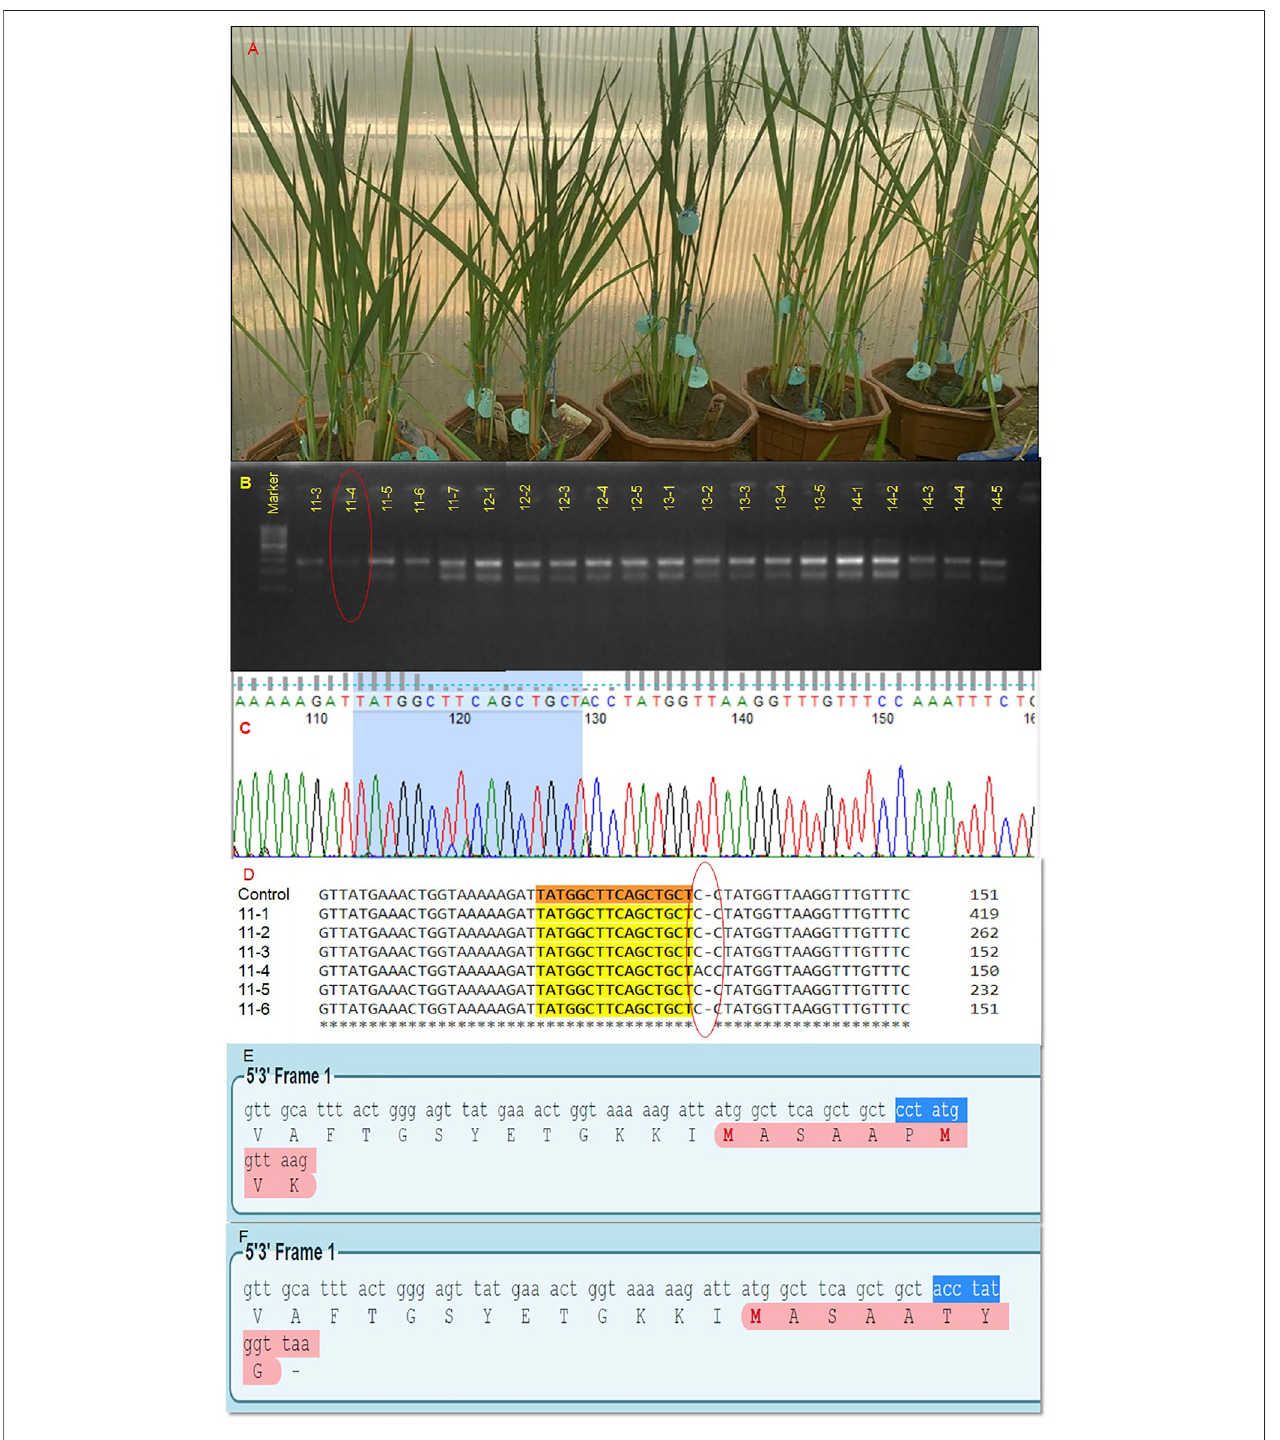
FIGURE 3 | Editing of OsBADH2 gene for generation of aromatic rice using RNP approach. Acclimatized T 0 edited plants for OsBADH2 gene grown under glasshouseconditions (A) ,DetectionofRNP-based editingintheT 0 generationthroughmutationsitebasedspeci fi cprimerstechnique(MSBSP).Encircledlanedepicts the mutation (B) , A electropherogram showing the result of Sanger sequencing (C) , Multiple sequence alignment of putative T 0 plants showing the addition of a nucleotide “ A ” 4-bp upstream of the PAM site (D) , The ORF of OsBADH2 exon seven in PR114 (E) , The ORF of Osbadh2 exon seven in the edited plant, 11-4 showing change in the last four amino acid sequences indicating the disruption of protein chain (F) .